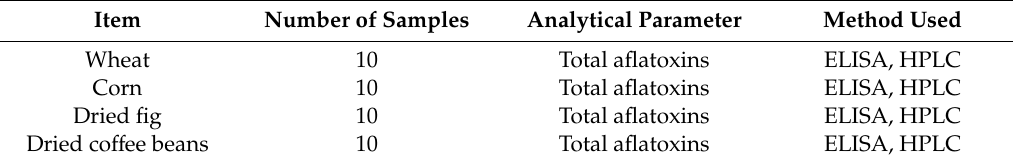
Table 1. Forty di ff erent samples have been collected from local markets in Amman, Jordan, during 2017-2018. The analytical plan included enzyme-linked immunosorbent assay (ELISA) and high-performance liquid chromatography (HPLC) analyses on all samples.